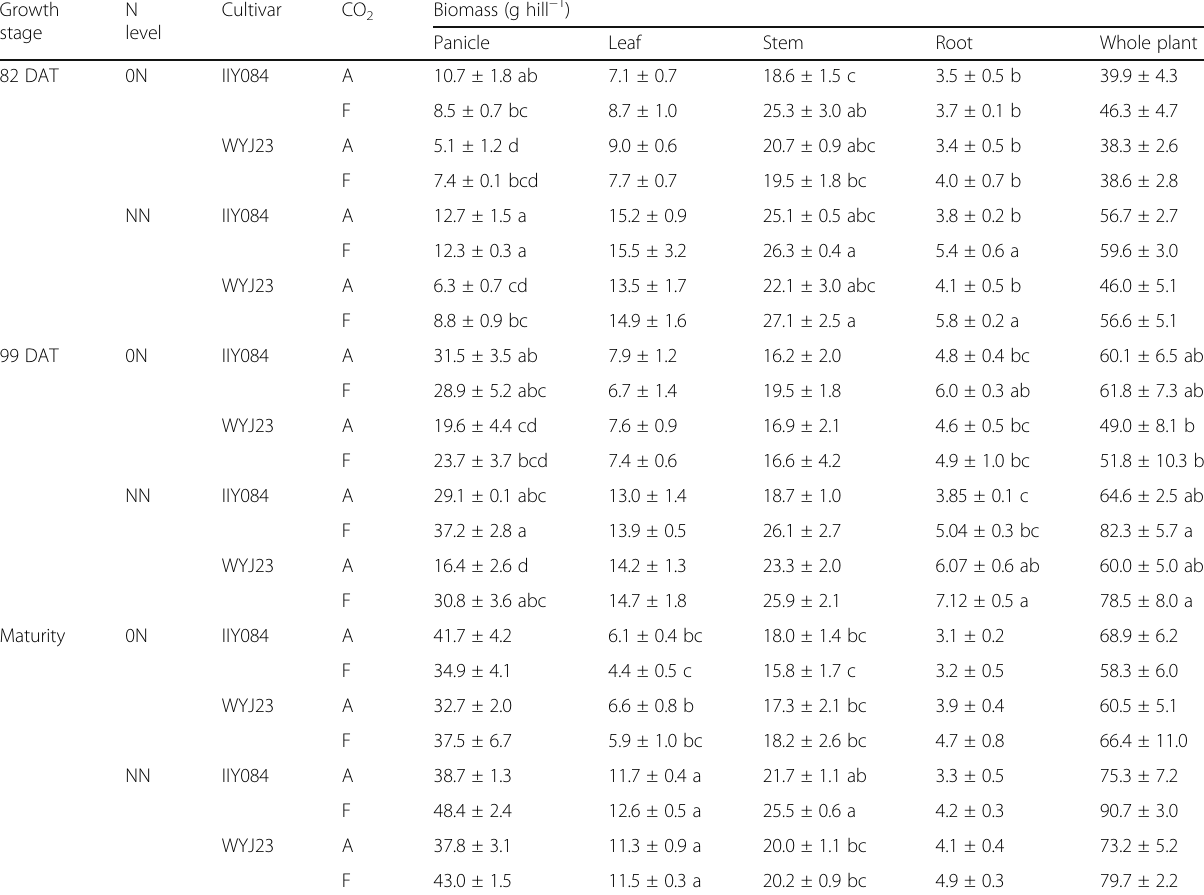
Table 1 Biomass of four tissues and whole plants of two cultivars (IIY084 and WYJ23) subjected to ambient (A) and elevated [CO 2 ] (F) at none (0N) and normal N levels (NN) at three stages Growth